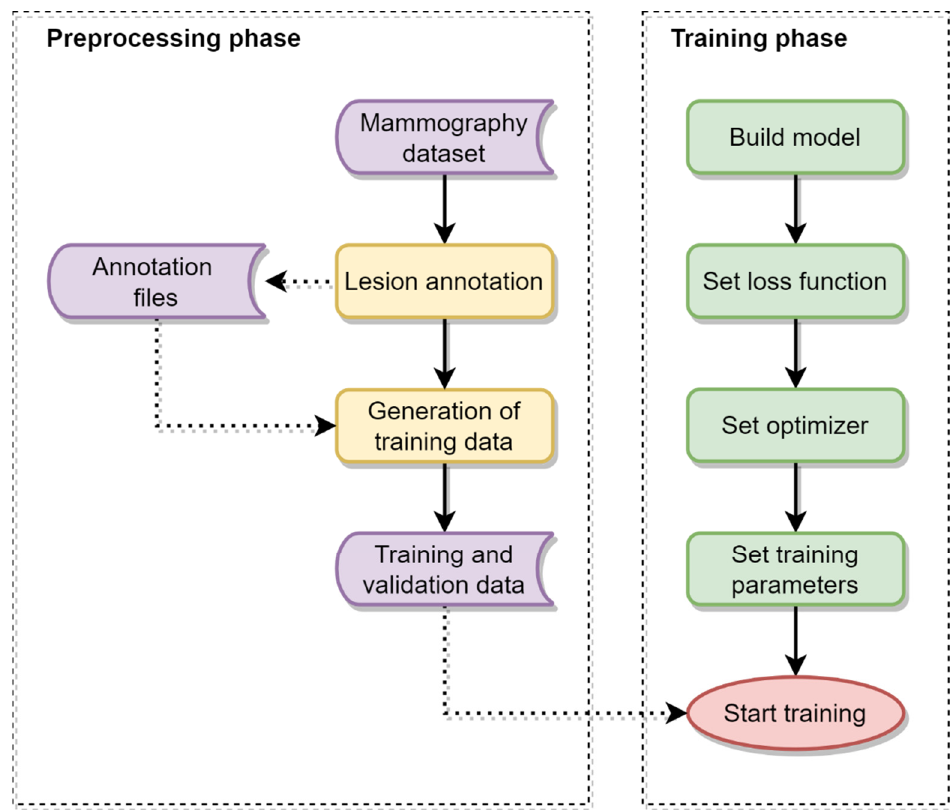
Figure 3. Flowcharts of the preprocessing and training phase in this work.